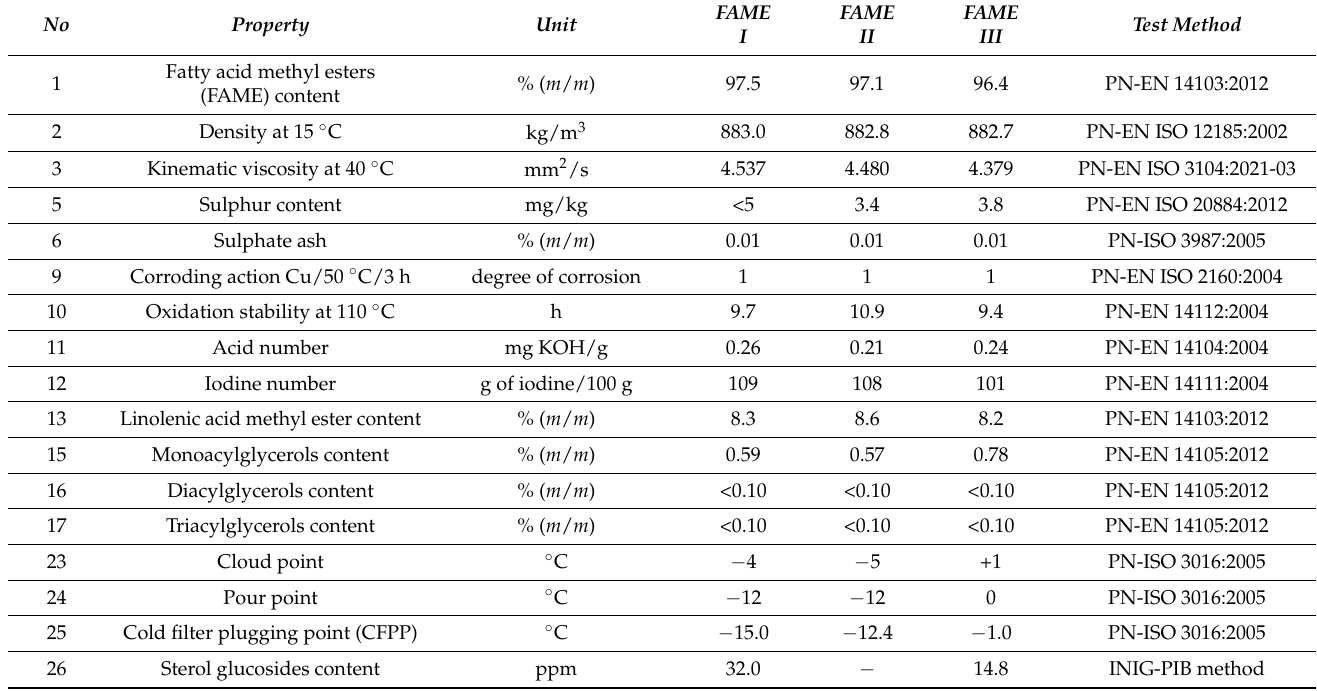
Table 1. Properties of studied fatty acid methyl esters (FAME).